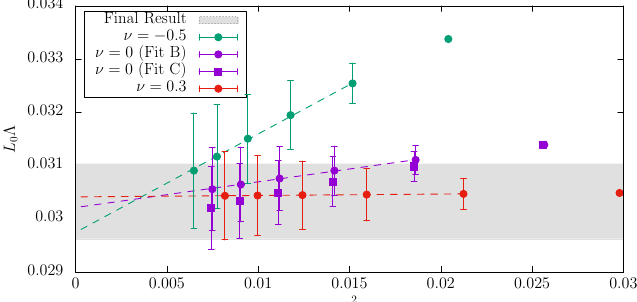
Λ N f = 3 / µ 0 at different values of α SF, ν = 0 ≡ 0.5,0,0.3 ) , and show a comparison with the final result −